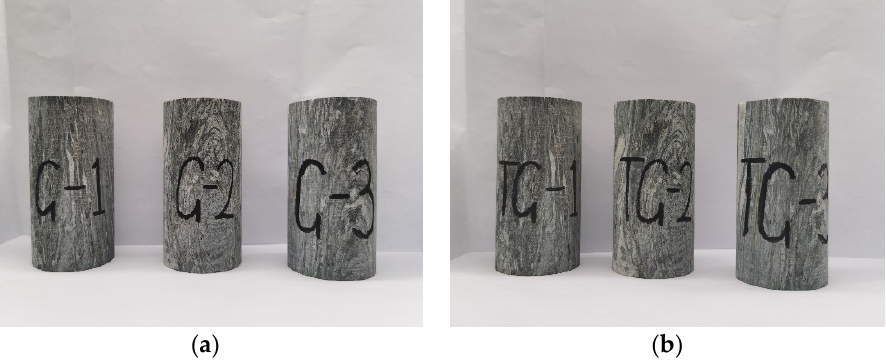
Figure 1. Gneiss specimens. ( a ) Gneiss specimens in the high geostress area for the uniaxial com- pression test. ( b ) Gneiss specimens in the high geostress area for the triaxial compression test.